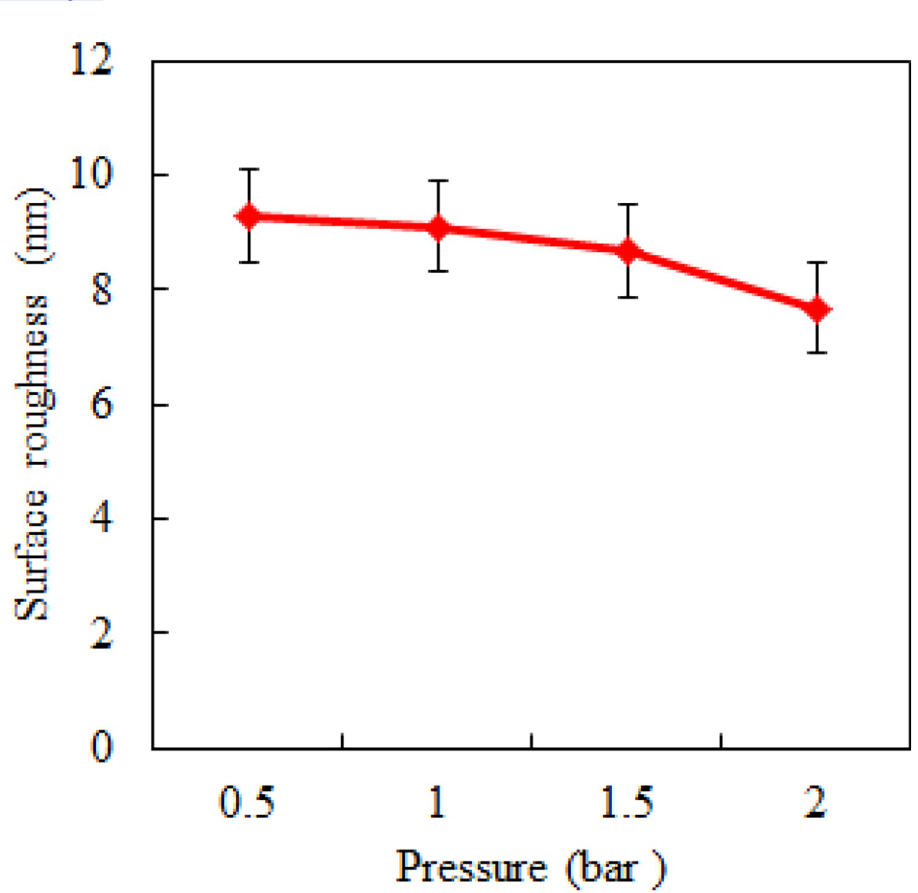
Fig 7. Effect of pressure on surface roughness. https://doi.org/10.1371/journal.pone.0272387.g007 PLOS ONE | https://doi.org/10.1371/journal.pone.0272387 August 1,